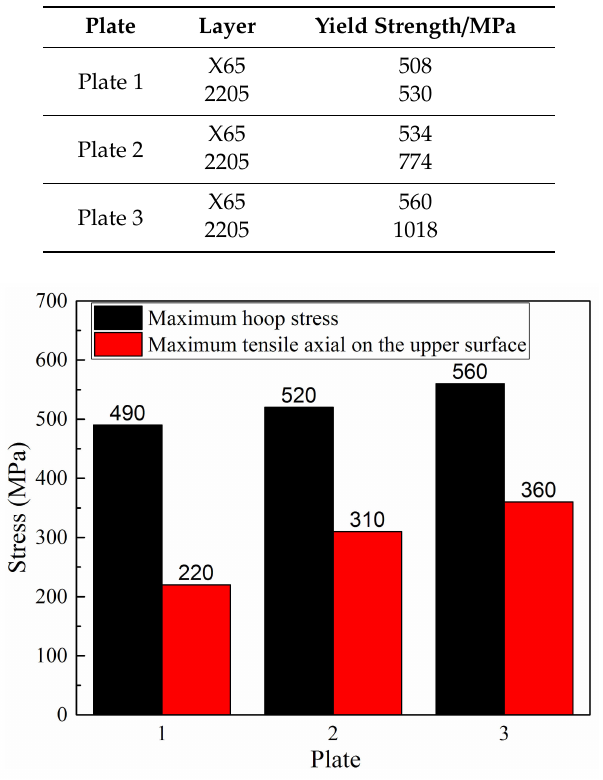
Figure 15. E ff ect of the plate strength on the residual stress.